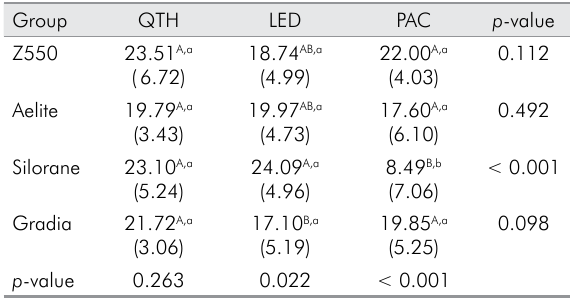
Table 3. Mean and Standard Deviation Values of Micros- hear Bond Strength(MPa)for Each